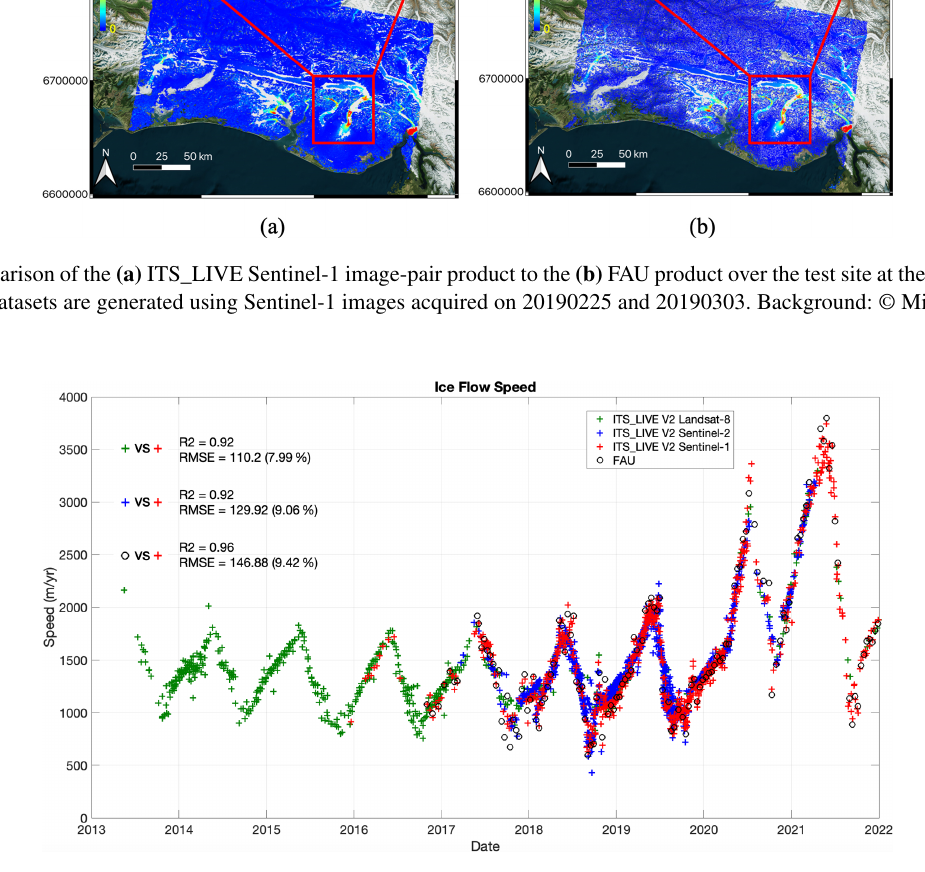
Figure 21. Time series of ITS_LIVE Sentinel-1 image-pair velocities, FAU velocities, and ITS_LIVE Version 2 Sentinel-2 and Landsat- 8 products for Alaska’s Malaspina Glacier for the location of the red cross marker (60.08 ◦ N, 140.47 ◦ W) in Fig. 19. The inter-product comparison metrics are also shown. The comparison includes 715 ITS_LIVE Sentinel-1, 653 ITS_LIVE Version 2 Landsat 8, 1131 ITS_LIVE Version 2 Sentinel-2 image-pair products as well as 134 FAU velocities. The time separation between repeat images ranges between 16 and 288d for Landsat 8 and between 5 and 280d for Sentinel 2